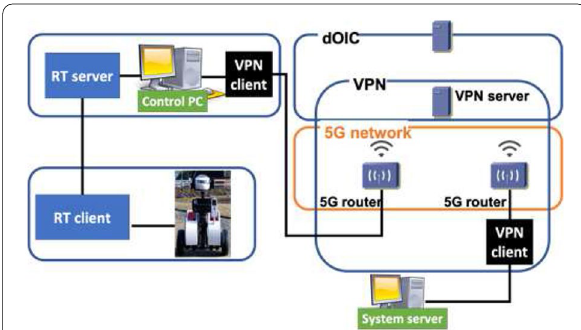
Fig. 15 Configuration of the 5G network. The control PC in the robot and the server PC are connected to a 5G router. Each router is communicating through a VPN network. The reverse tethering system is adopted between the robot and the control